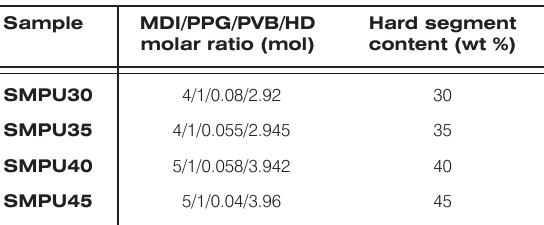
Table 1. SMPUs molar